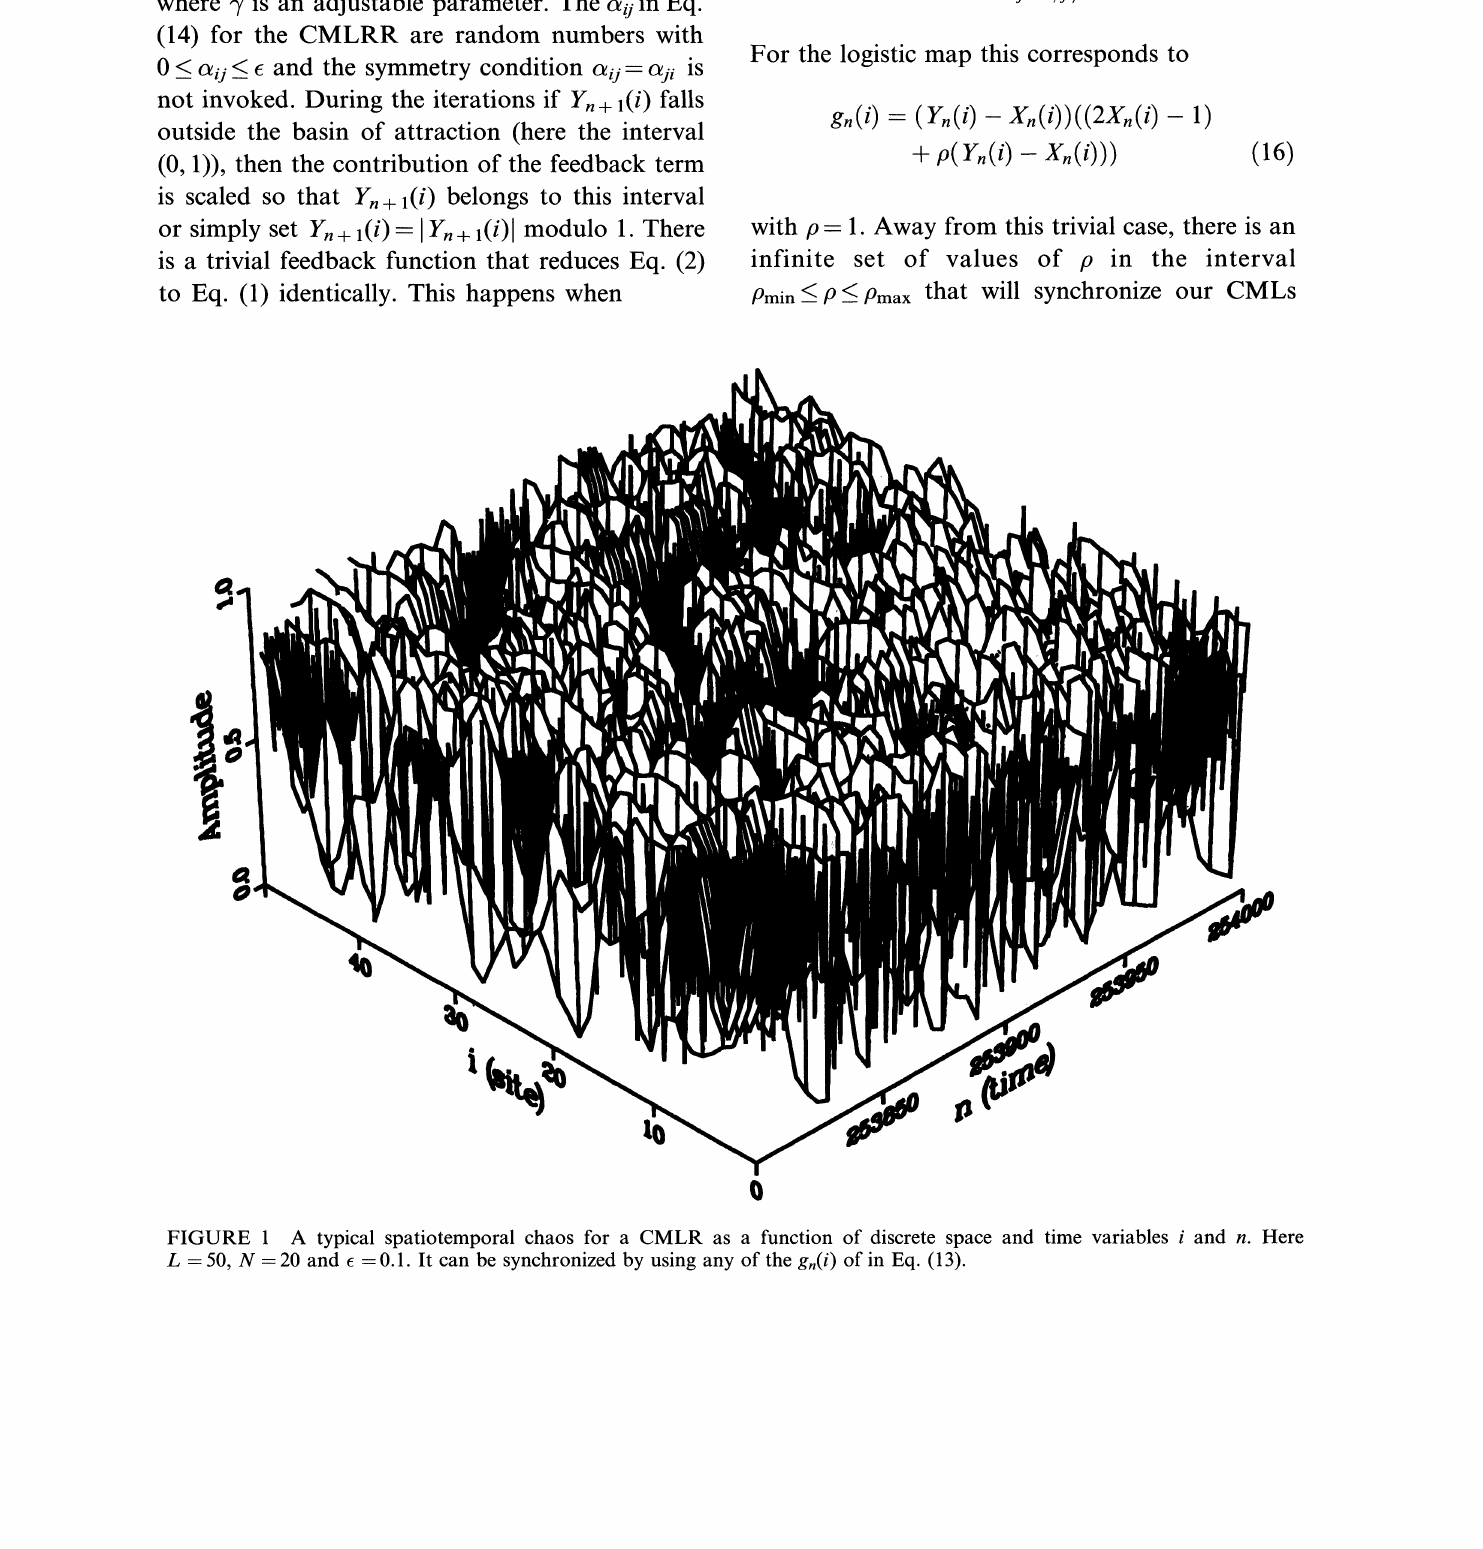
FIGURE A typical spatiotemporal chaos for a CMLR as a function of discrete space and time variables and n. Here L 50, N 20 and =0.1. It can be synchronized by using any of the g,,(i) of in Eq.